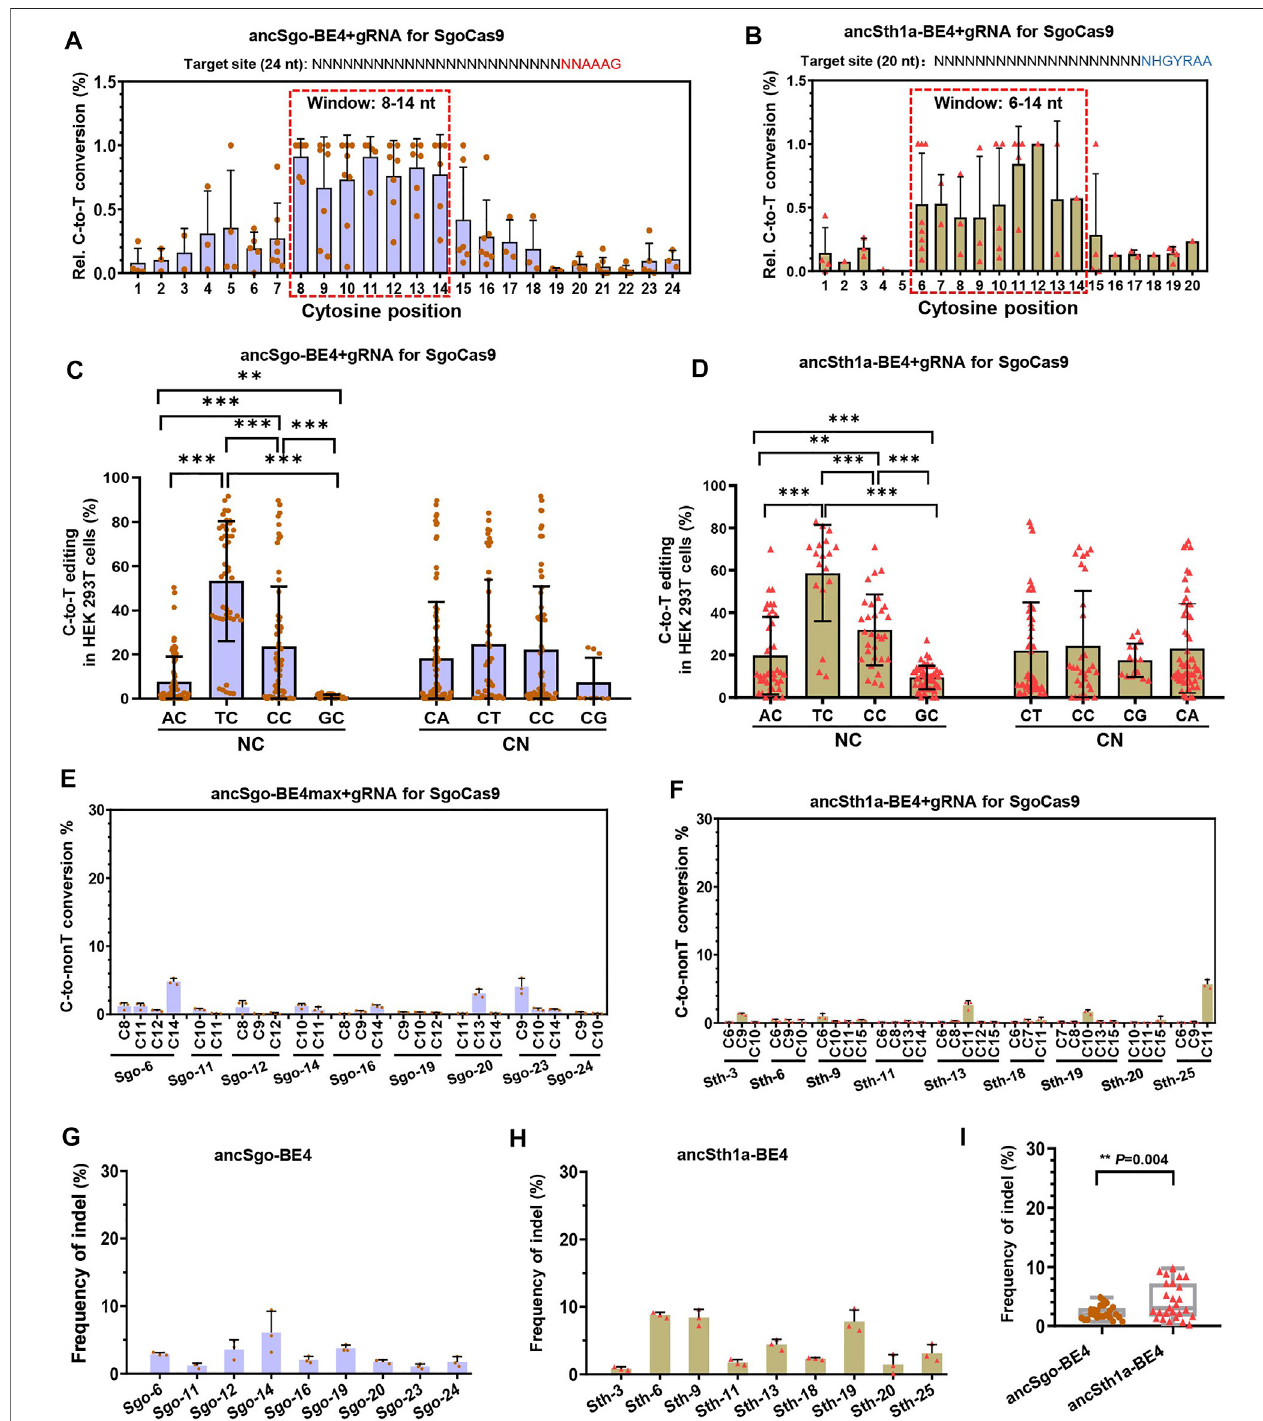
FIGURE 2 | Characterization of editing features induced by ancSgo-BE4 and ancSth1a-BE4. (A,B) The C-to-T conversion rate for the cytosine with the highest ef fi ciencyforeachsitewasnormalizedto “ 1 ” ,andrelative(Rel.)editingef fi cienciesforallcytosinesattheirpositionwithintheprotospacerwerepresented.Themostdistal nucleotide relative to PAM was set as position “ 1. ” The base editing windows for ancSgo-BE4 (A) and ancSth1a-BE4 (B) are highlighted by the dotted red box. (C,D) Comparison of base editing activity induced by ancSgo-BE4 (C) and ancSth1a-BE4 (D) in different neighboring contexts at the 5 ’ (NC) or 3 ’ (CN) ends of targeted cytosines (Student ’ s t -test). ** p < 0.01, *** p < 0.001. (E,F) C-to-non-T (C-to-G and C-to-A) editing ef fi ciency at 9 targeting sites induced by ancSgo-BE4 (E) and ancSth1a-BE4 (F) in HEK293T cells. Data were generated from targeted deep sequencing from three independent replicates. (G,H) Frequency of indels at 9 targeting sitesinducedbyancSgo-BE4 (G) andancSth1a-BE4 (H) inHEK293Tcells. (I) Comparisonoffrequenciesofindelsat9targetingsitesin G and H . P -valuewascalculated from unpaired, two-tailed Student ’ s t -test. ** p < 0.01.